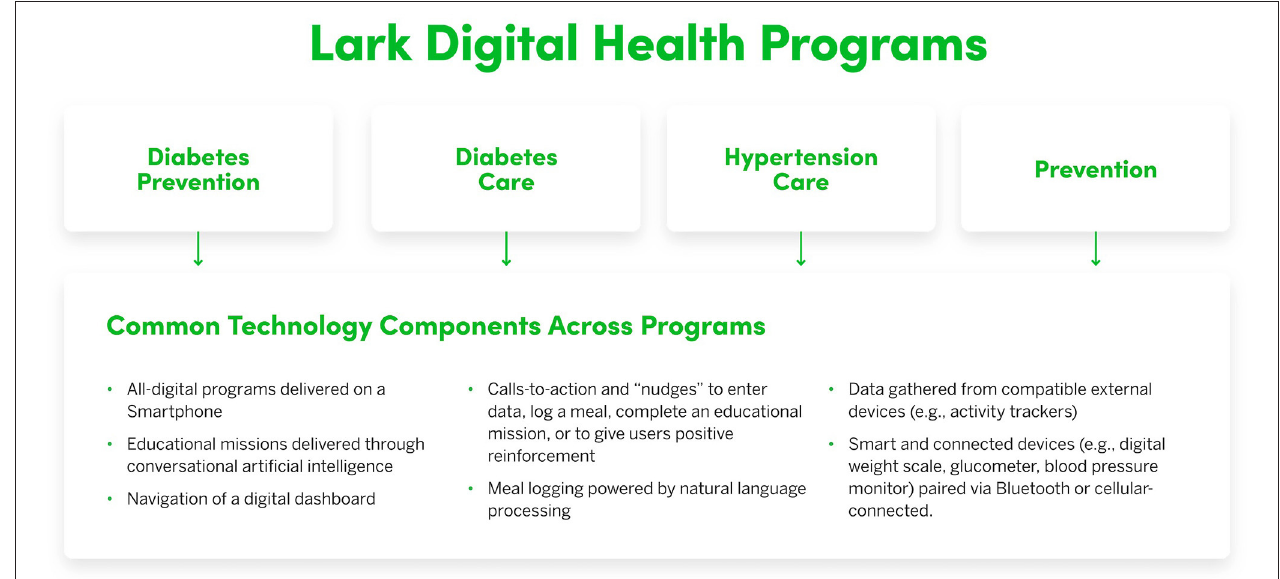
FIGURE 1 | Overview of the common technological components of the Lark digital health